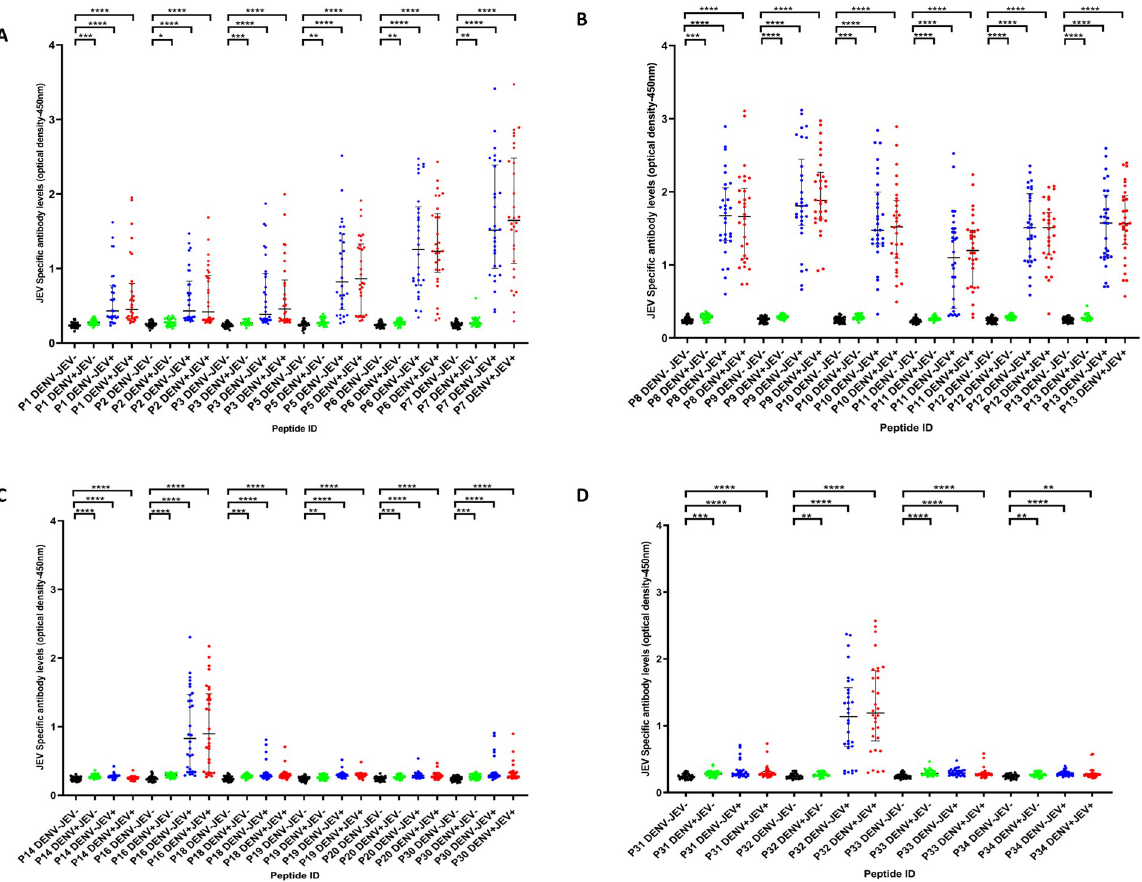
Fig 1. IgG antibody levels to 22 JEV-specific peptides in individuals with varied DENV and JEV seropositivity. JEV-specific antibody responses were measured by ELISA to 22 JEV-specific peptides in those who were both JEV and DENV seropositive (JEV + DEV + , n = 30), JEV seropositive but seronegative for DENV (JEV + DEV - , n = 30), DENV seropositive but JEV seronegative (JEV - DENV + , n = 30) or seronegative for both (JEV - DENV - , n = 30). Error bars indicate the median and the interquartile range. The horizontal dotted line represents the cut-off value of 0.382, which was considered as the mean, ± 3SD of the optical density of antibody levels in JEV - and DENV - seronegative. � P < 0.05, �� P < 0.01, ��� P < 0.001, ���� P < 0.0001. The differences in the responses to the JEV-specific antibodies were assessed by Mann Whitney two-tailed test.